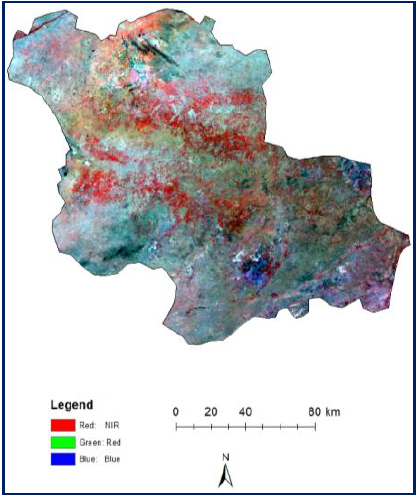
Fig.3. FCC MODIS Image of Study Area